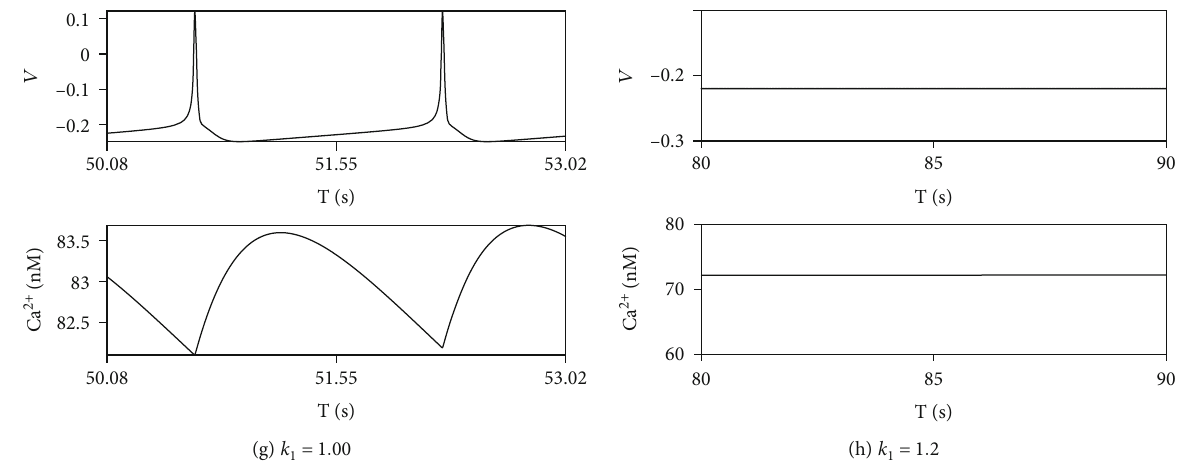
Figure 8: The neuron fi ring modes and Ca 2+ activities as r